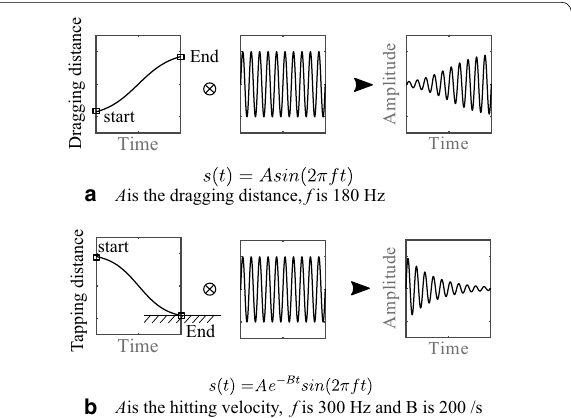
Fig. 5 Waveforms for vibrotactile actuator during gesture execution. Waveforms for vibrotactile actuator. a Haptic spring mode: the amplitude of the vibrotactile waveform increases with dragging or zoom distance (Concurrent feedback). b Haptic impulse mode: Asymptotically decreasing sinusoidal waveform at the end of tapping gesture whose amplitude corresponds to hitting speed (Terminal